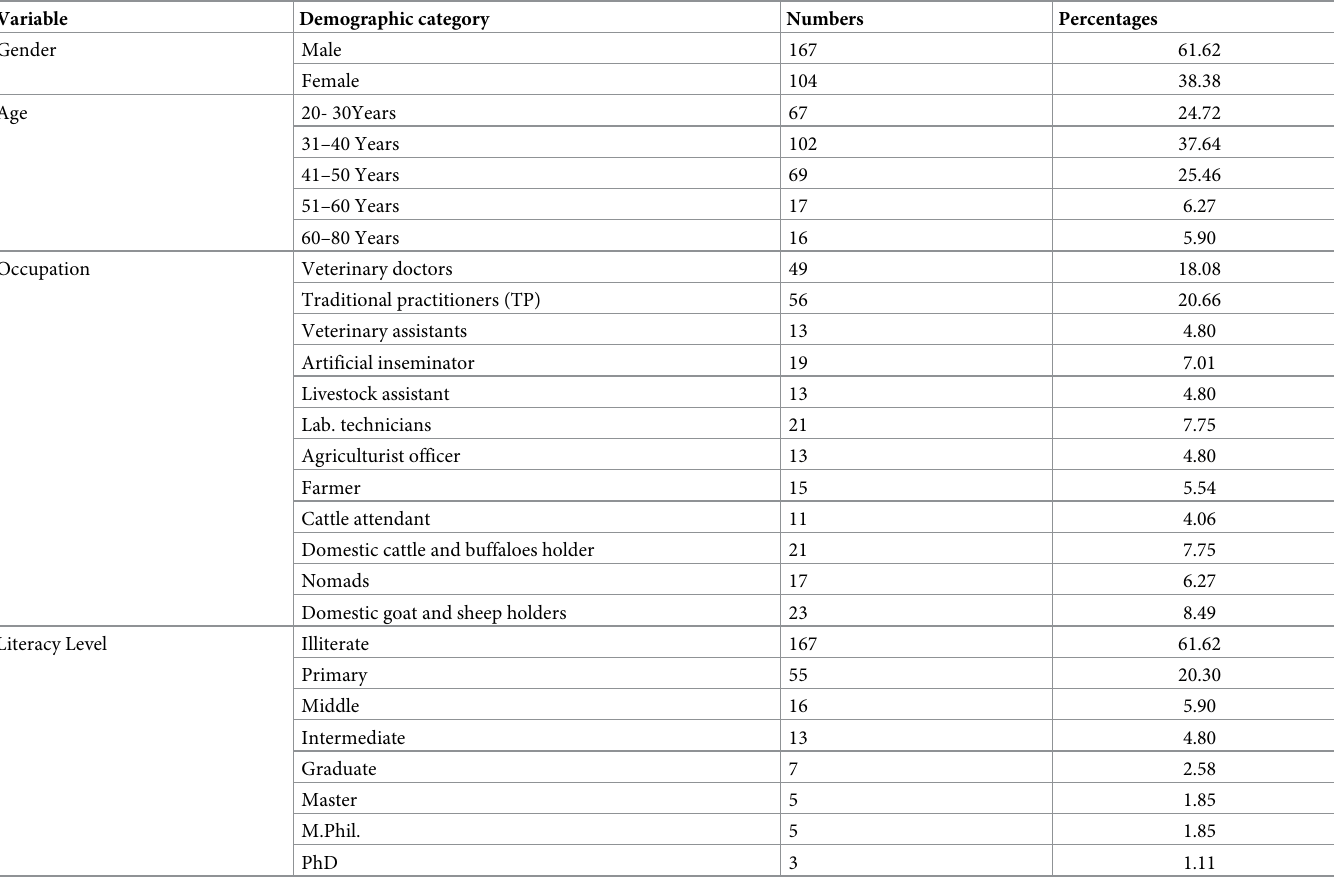
Table 1. Demographic characteristics of the informants selected from the study